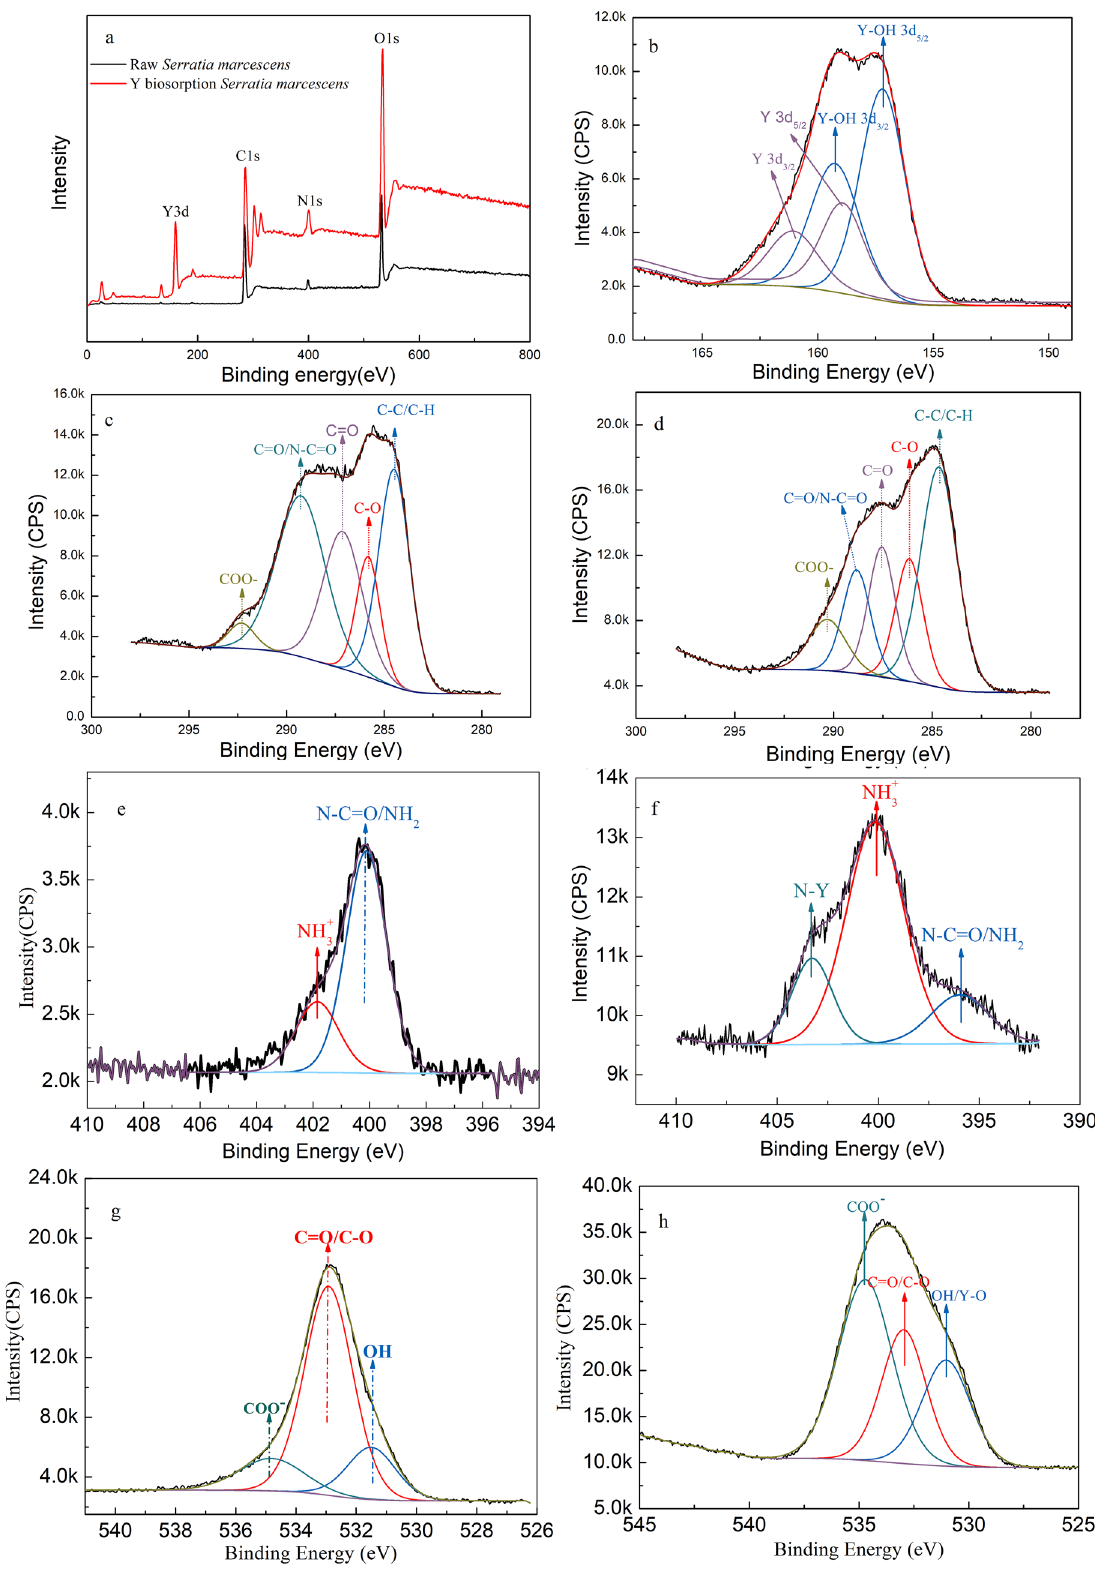
Figure 7. XPS spectra of S. marcescens . Survey spectra of S. marcescens before and after Y(III) biosorption ( a ), Y3d spectra of S. marcescens after Y(III) biosorption ( b ), C1s spectra of S. marcescens before ( c ) and after Y(III) biosorption ( d ), N1s spectra of S. marcescens before ( e ) and after Y(III) biosorption ( f ), O1s spectra of of S. marcescens before ( g ) and after Y(III) biosorption ( h